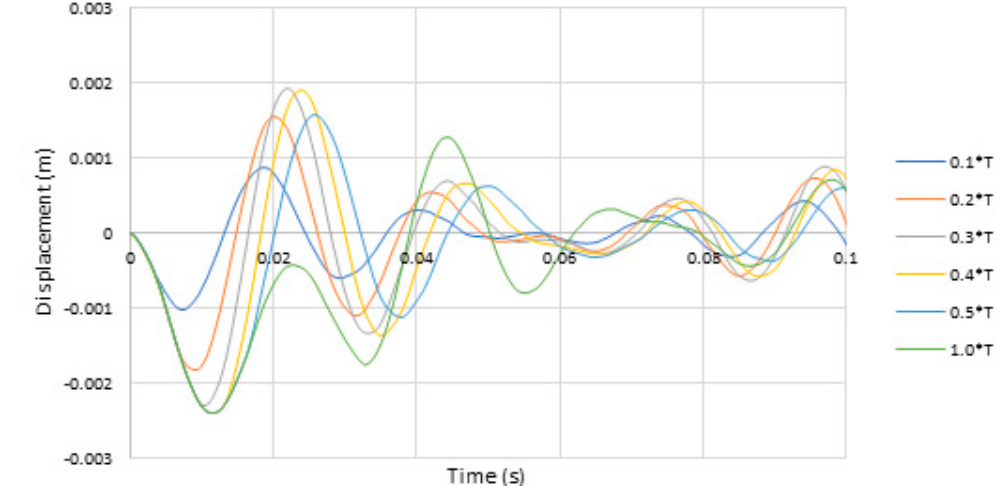
Figure 13. Vibration of loaded section under face force. Simulation results.